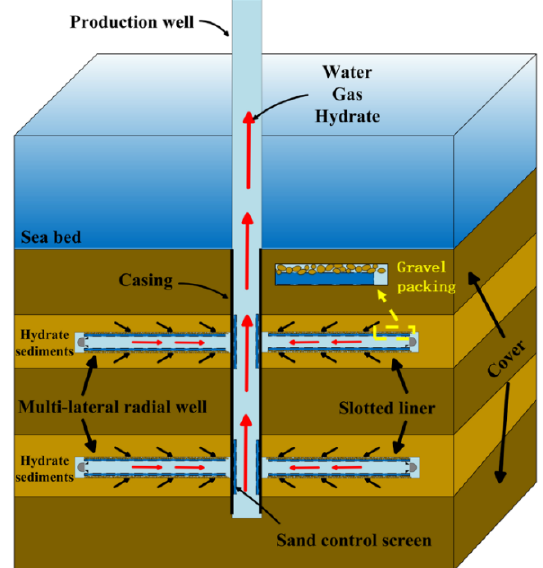
Figure 1. Schematic diagram of the integrated development of natural gas hydrate reservoirs by abrasive waterjet drilling radial well + liner completion.